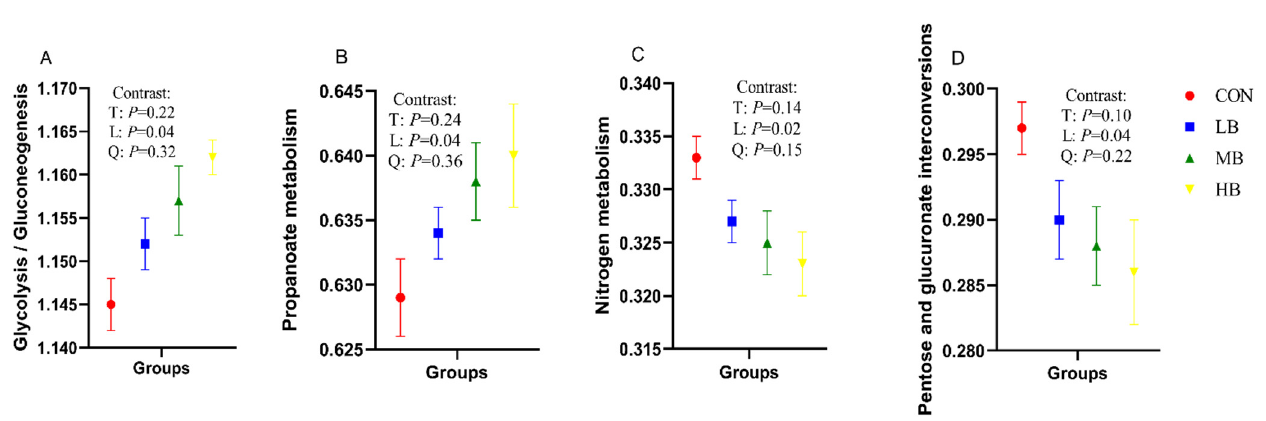
Figure 3. Predicted fecal bacterial function by PICRUSt analysis (KEGG level-3 pathways) of lactating Holstein cows fed diets with by-products substituted for forage. ( A ): Glycolysis/Gluconeogenesis; ( B ): Propanoate metabolism; ( C ): Nitrogen metabolism; ( D ): Pentose and glucuronate